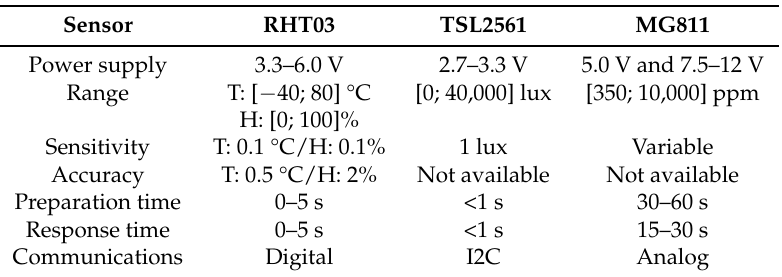
Table 3. Sensor features. Source: datasheets.